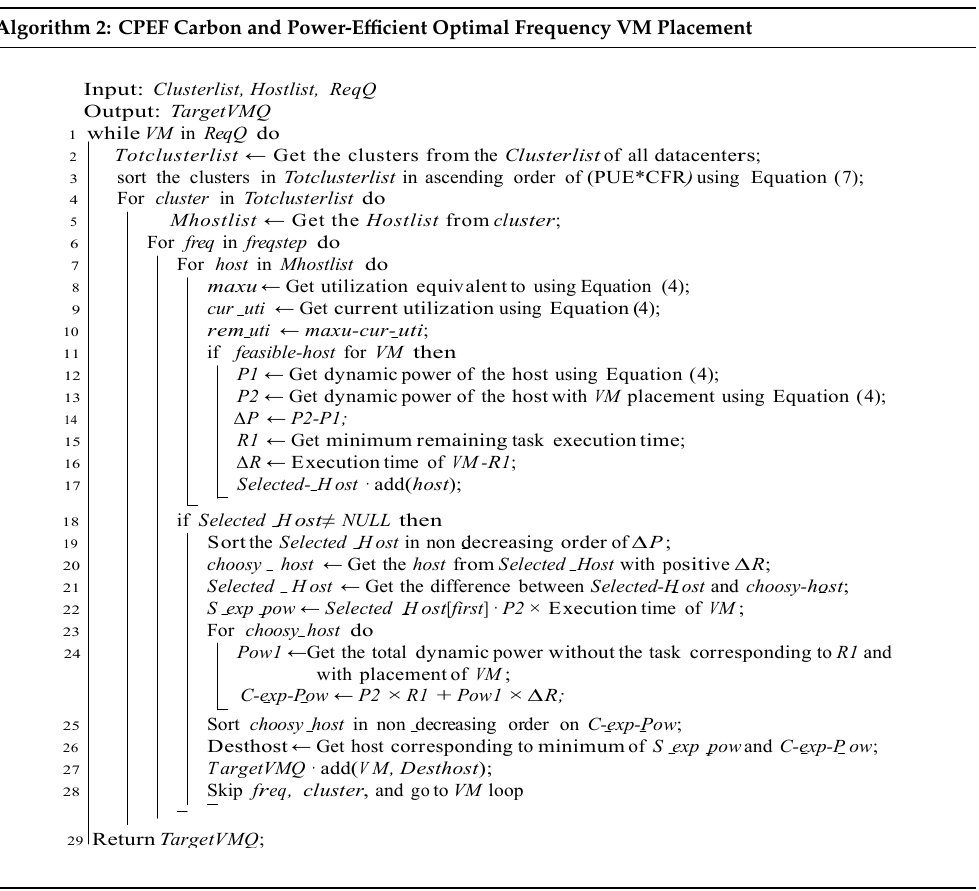
Algorithm 1: High-level overview of the algorithm approach